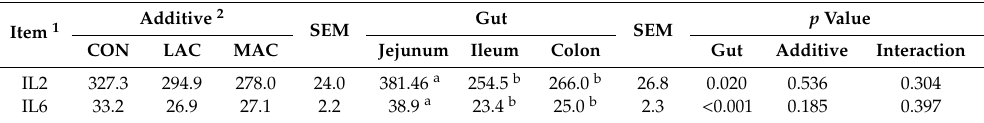
Figure 4. E ff ects of supplementing probiotics and prebiotics additives on the activities (U / mg · protein) of SOD (Panel A ) and GSH-Px (Panel B ) in the colon, ileum, and jejunum of young goats (Exp. 2). CON = control group; LAC = a control diet supplementing with 10 g / day Lactobacillus plantarum P-8; MAC = a control diet supplementing with 0.3 g / day plant extract (Sangrovit ® , MAC extract 3.75% w / w premix). a, b Row means that do not have a common superscript di ff er ( p < 0.05). Table 2. E ff ects of probiotics and prebiotics additives on concentrations (pg / mg · protein) of IL2 and IL6 in the colon, ileum and jejunum of young